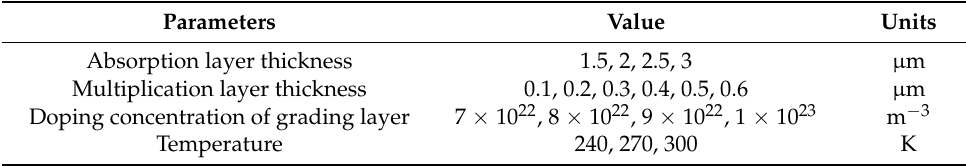
Table 1. The important parameters used in the simulation.